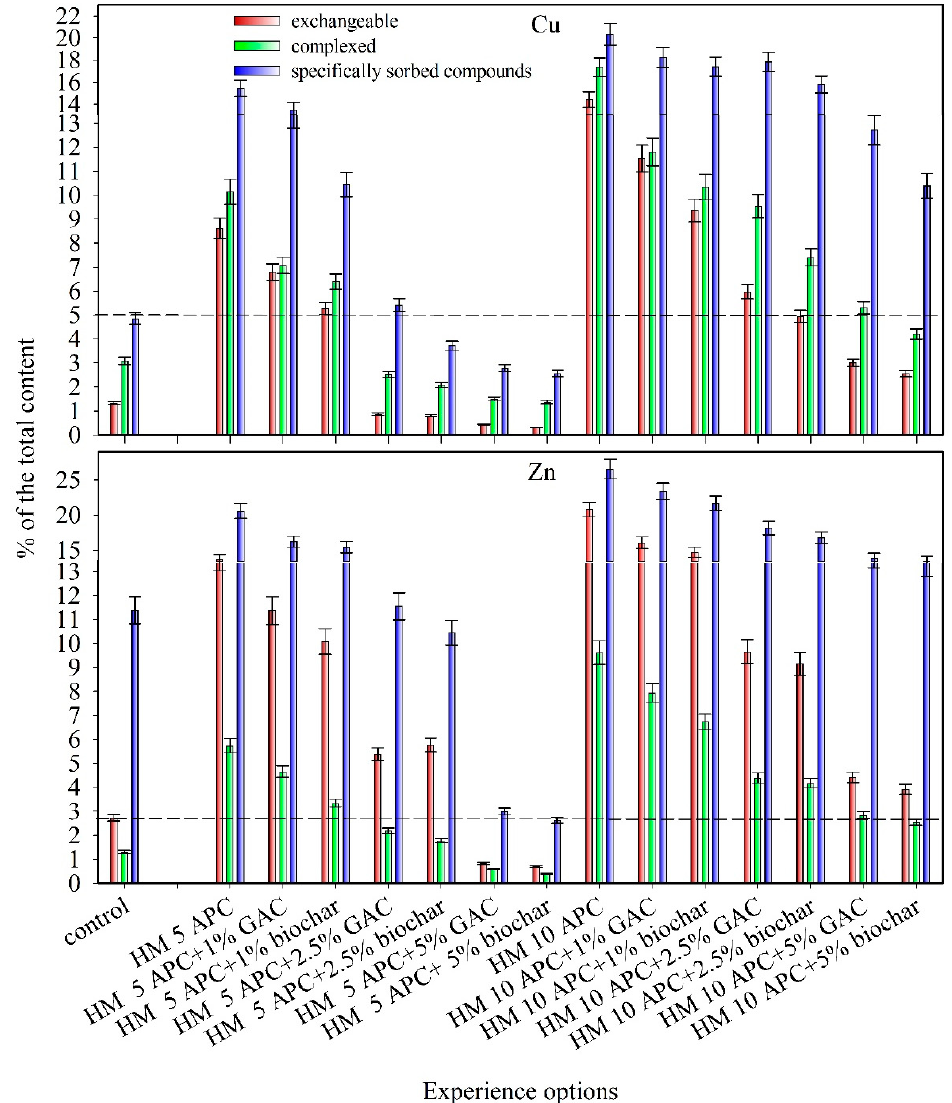
Figure 2. The proportion of loosely bound compounds of Cu and Zn in the soil of the model experiment under contamination with doses of 5 and 10 approximate permissible concentrations (APC) of heavy metal (HM), % of the total content.